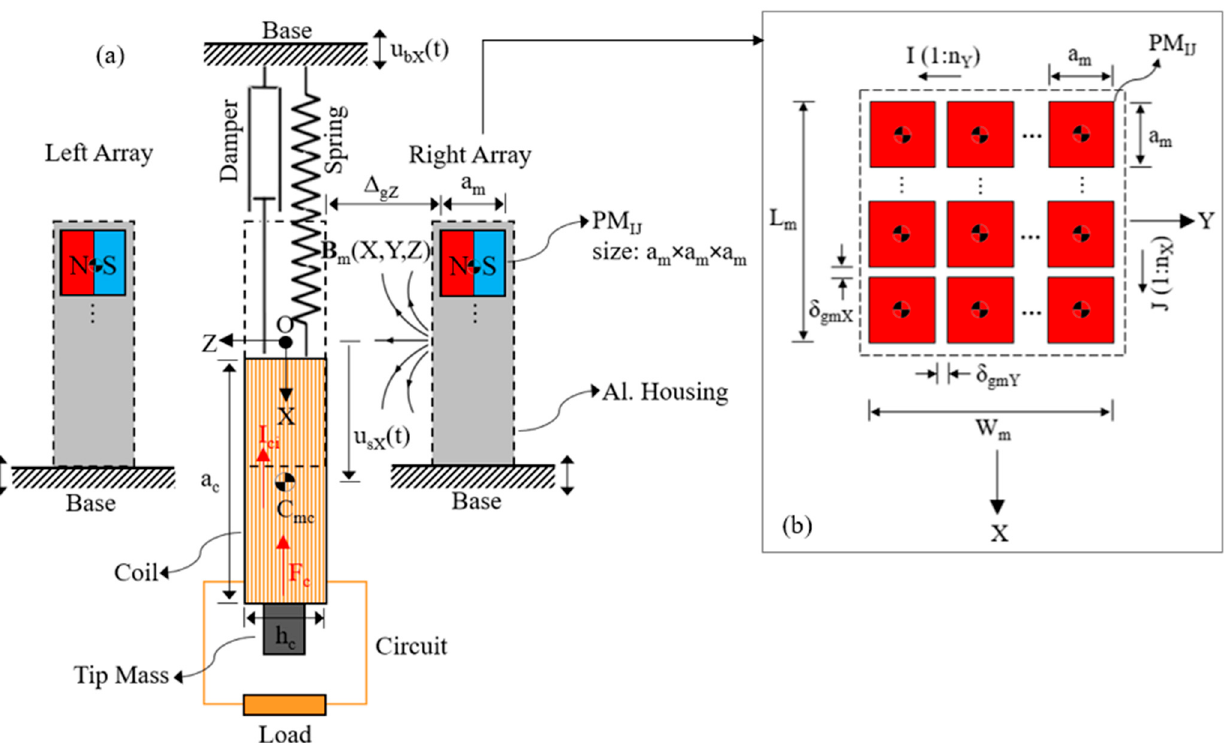
Figure 1. Configuration of the EMEH and its key components. ( a ) Vertical cross section of the EMEH in the XZ-plane. ( b ) Geometrical parameters of the arrays in details.